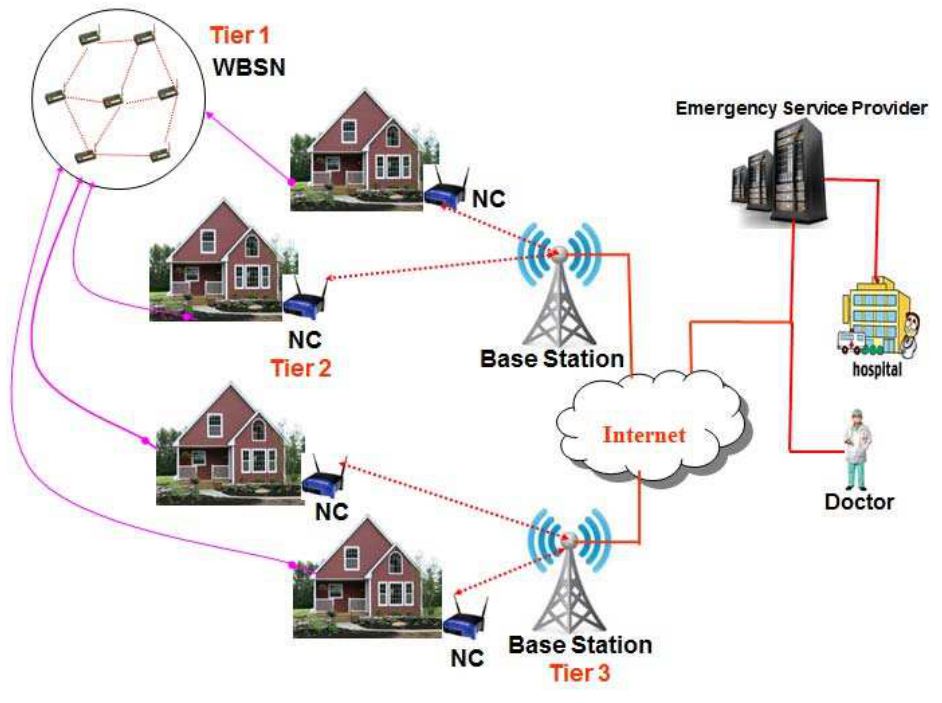
Figure 1. The proposed three tier Wireless Body Sensor Networks.